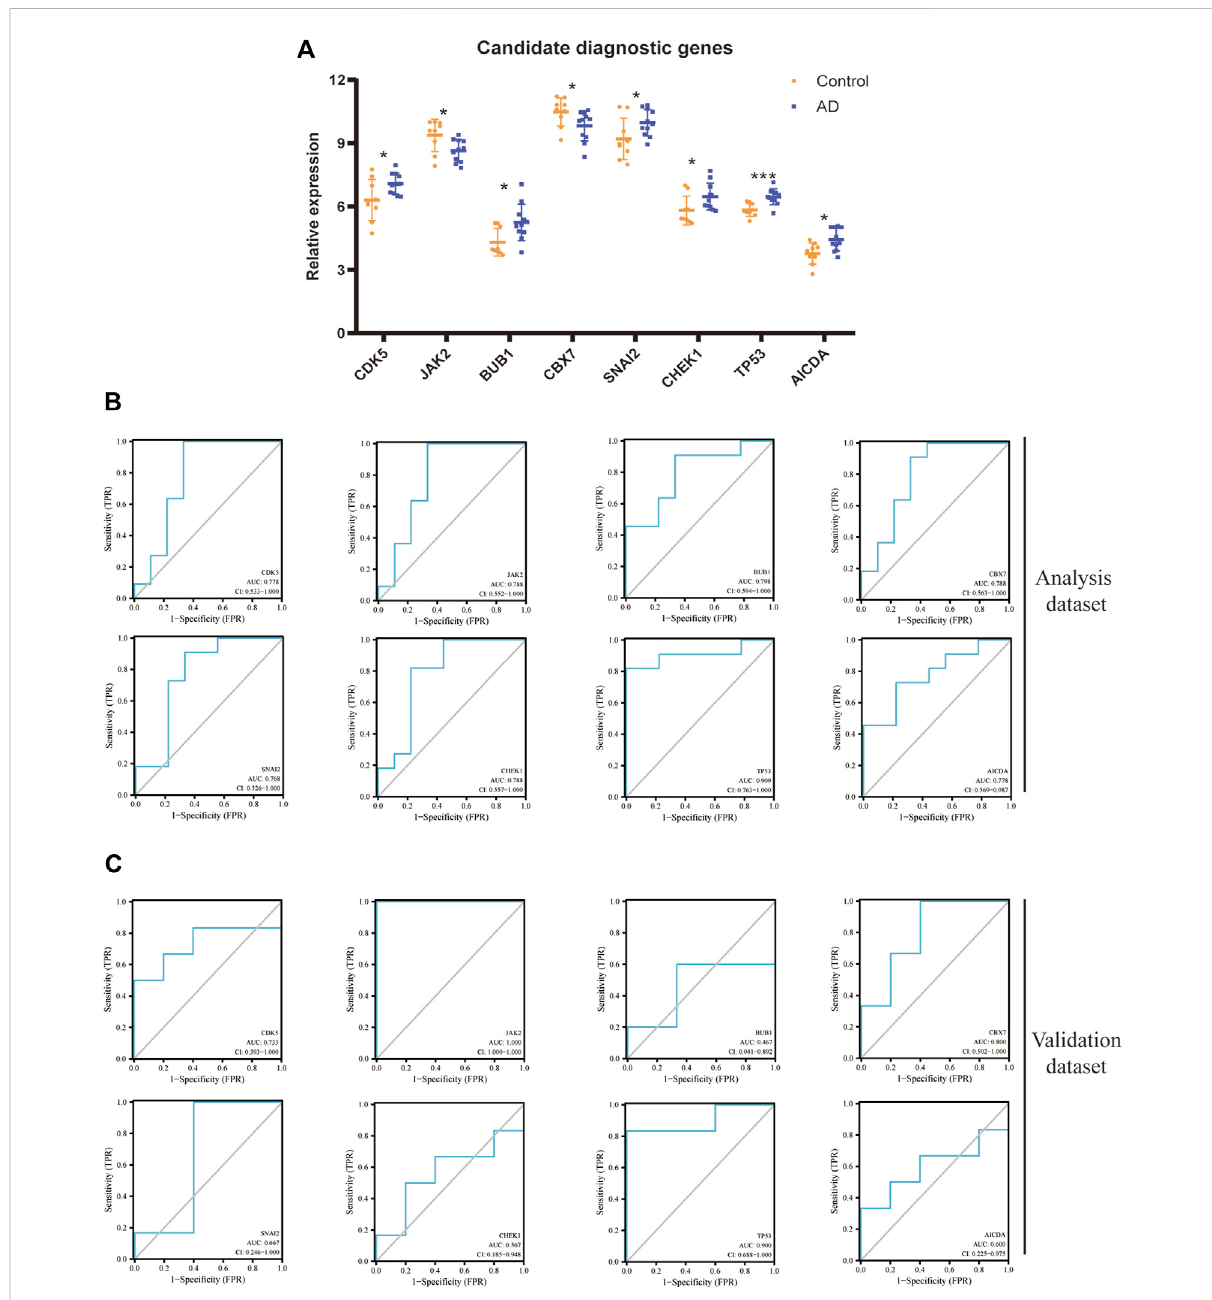
FIGURE 5 Diagnostic value of each DECR. (A) Statistical analyses regarding expression of eight candidate DECRs between samples from AD cases and healthy controls. Yellow and blue plots represent healthy-control and AD samples, respectively. * p < 0.05; *** p < 0.001. (B) The ROC curve of each candidate DECR shows the diagnostic value. The AUC and 95%CI are listed at the bottom. (C) The other validation dataset of AD was applied to analyzethediagnosticvaluerevealedbytheROCcurve.AbbreviationsDECR,differentiallyexpressedchromatinregulator;AD,aorticdissection; ROC, receiver operating characteristic; AUC, area under the ROC curve; CI, con fi dence